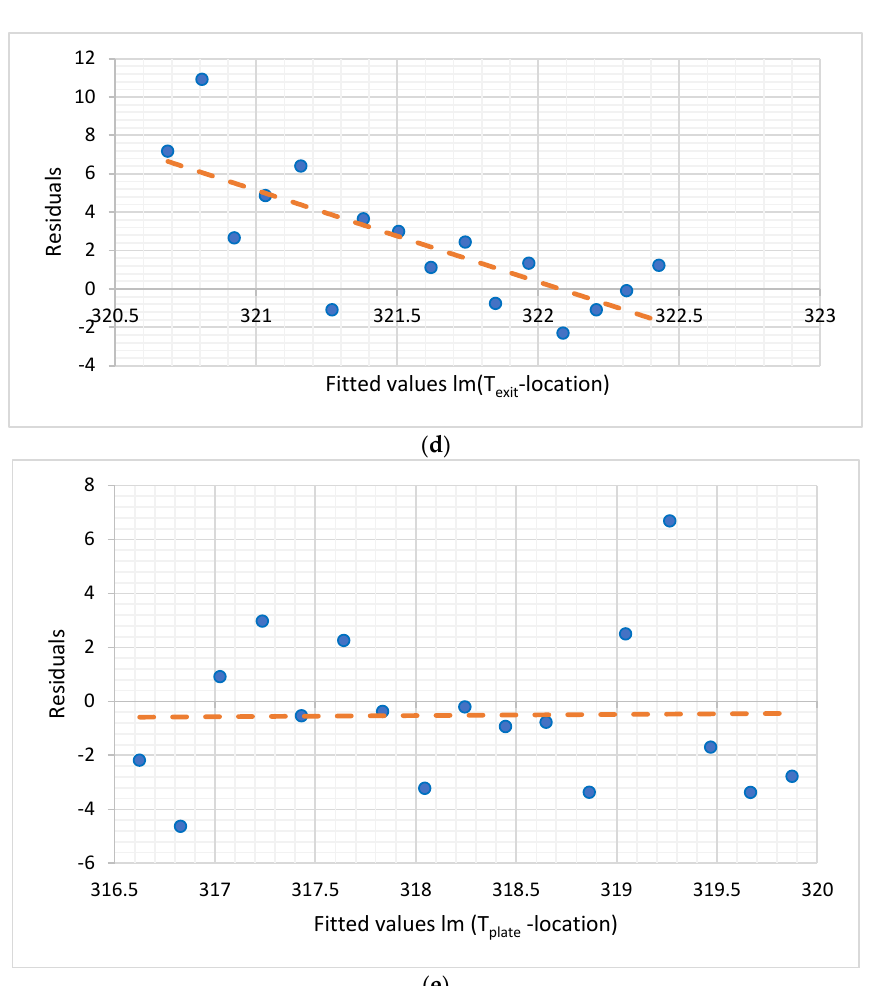
Figure 4. ( a ) Comparison of velocity profile U y of hot air within the chamber predicted by 3 different CFD models for suction velocity, Vs = 0.077 m/s. ( b ) Comparison of plate temperature predicted by 3 different CFD models for suction velocity, Vs = 0.077 m/s. ( c ) Box plots show the range and characteristics of plate temperature predicted by 3 different CFD models for suction velocity, Vs = 0.077 m/s. ( d ) Scatter plot for the distribution of exit temperature T exit (fitted value) versus location. ( e ) Scatter plot for the distribution of plate temperature (fitted value) versus location.